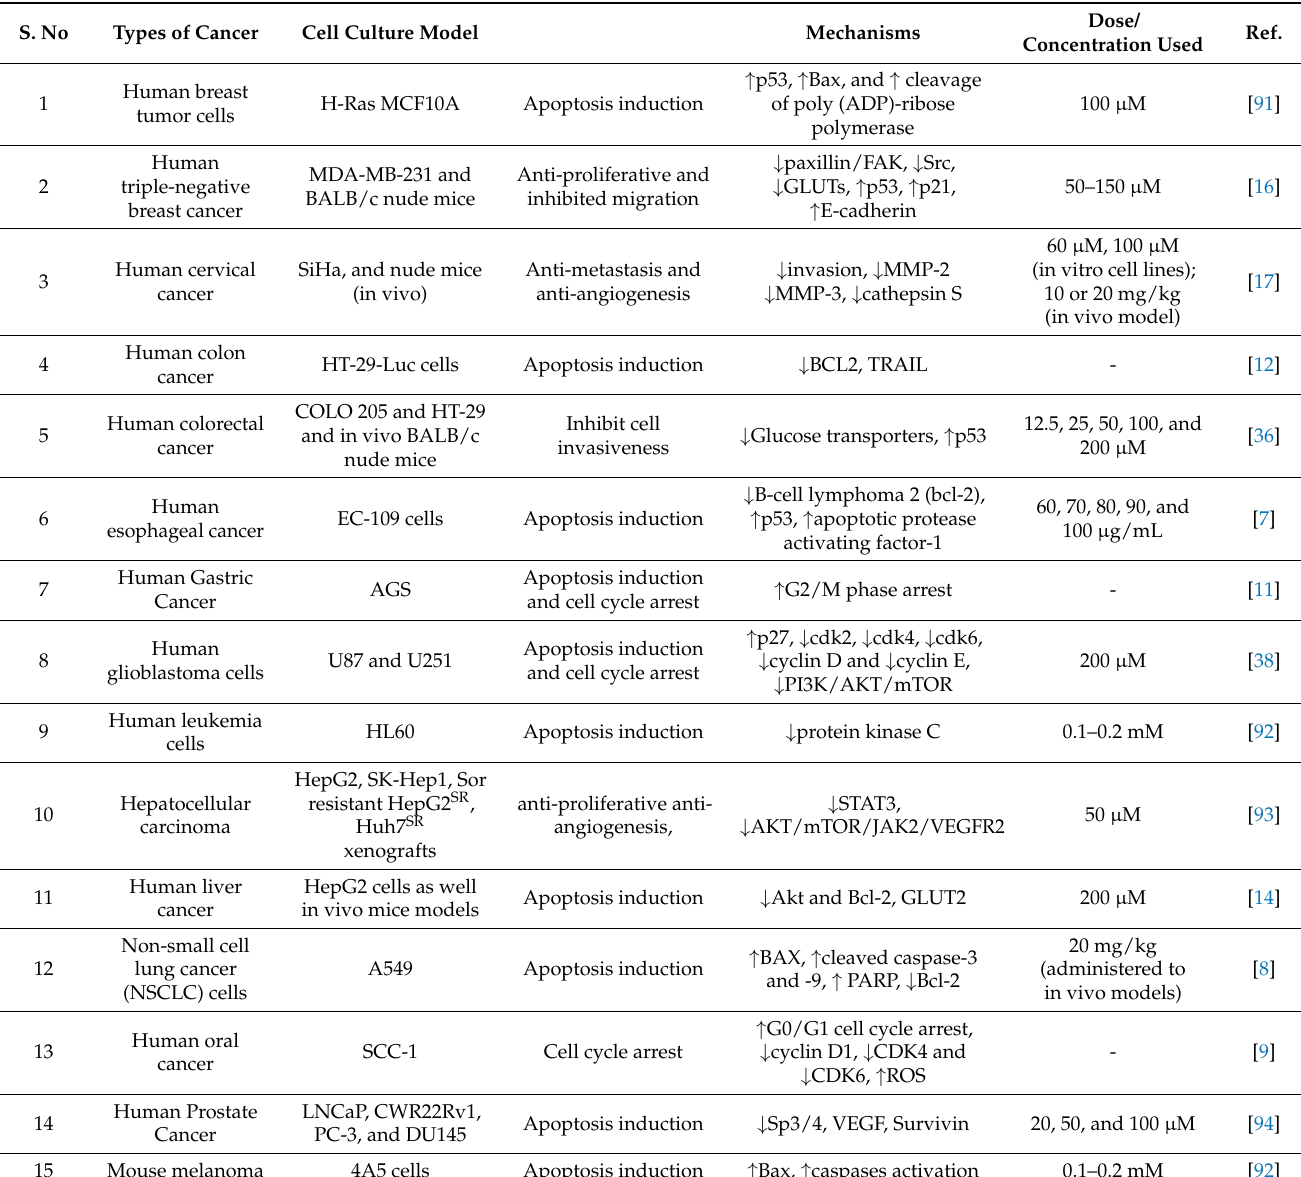
Table 1. Representation of various anticancer studies of phloretin. Arrows designate up ( ↑ ) and downregulation ( ↓ ) of the